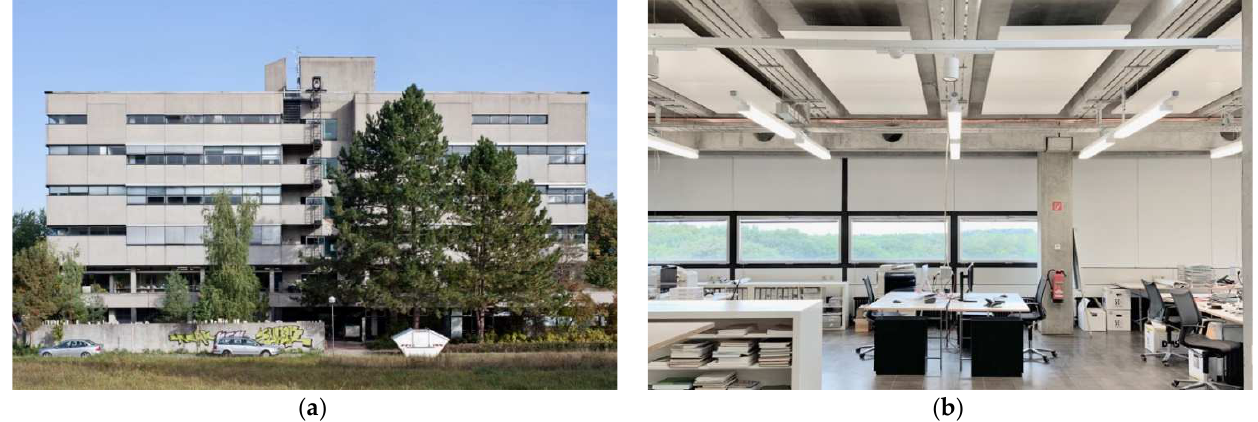
Figure 1. The ( a ) current state (2020) of the architecture building (Photo: Jakob Philipp Weise) and ( b ) interior view after installation of suspended heating panels (5th floor) (Photo: David Sauerwein).